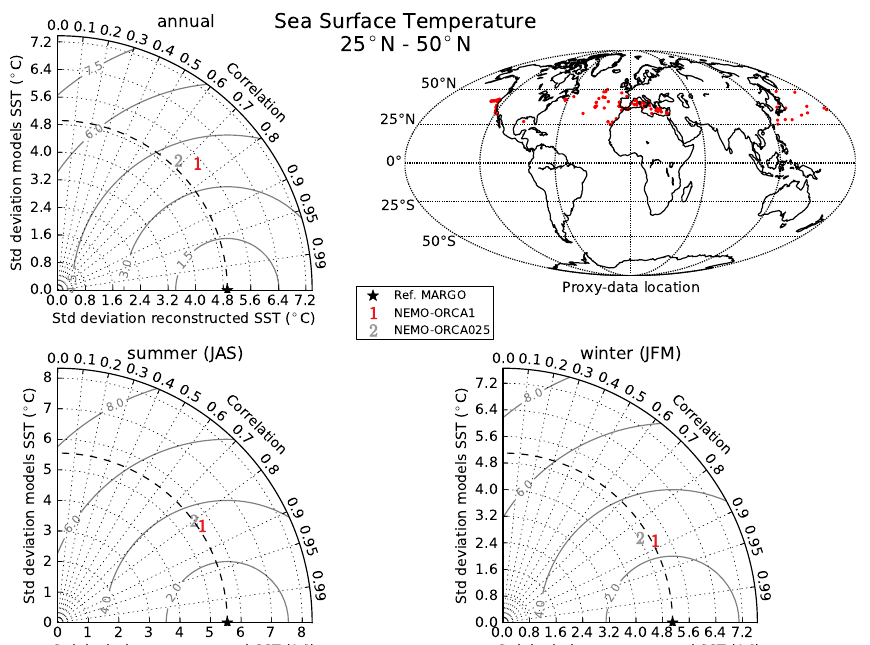
Fig. 10. Taylor diagrams summarizing the correlation coefficient, the standard deviations and RMSE for the LGM annual, boreal winter (JFM) and boreal summer (JAS) modelled and reconstructed sea surface temperatures between 25 and 50 ◦ N. The proxy-data locations are shown in the upper right-hand diagram. The NEMO-ORCA1 is symbolized with the number 1, NEMO-ORCA025 with the symbol 2.